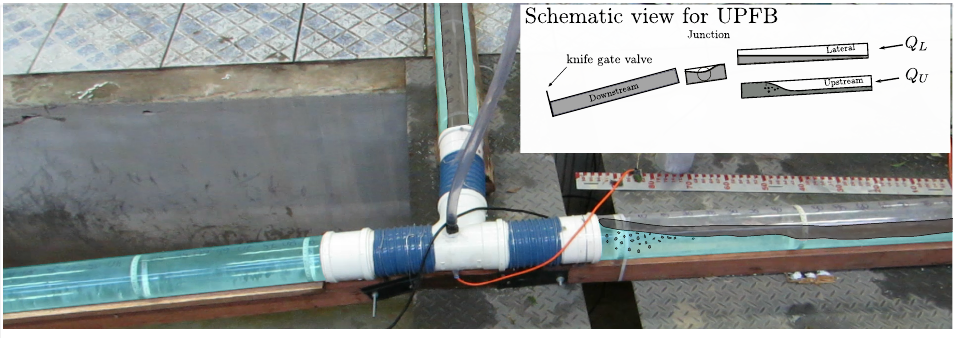
Figure 5. Visualization at some seconds after the knife gate closure showing the pressurization process for UPFB.